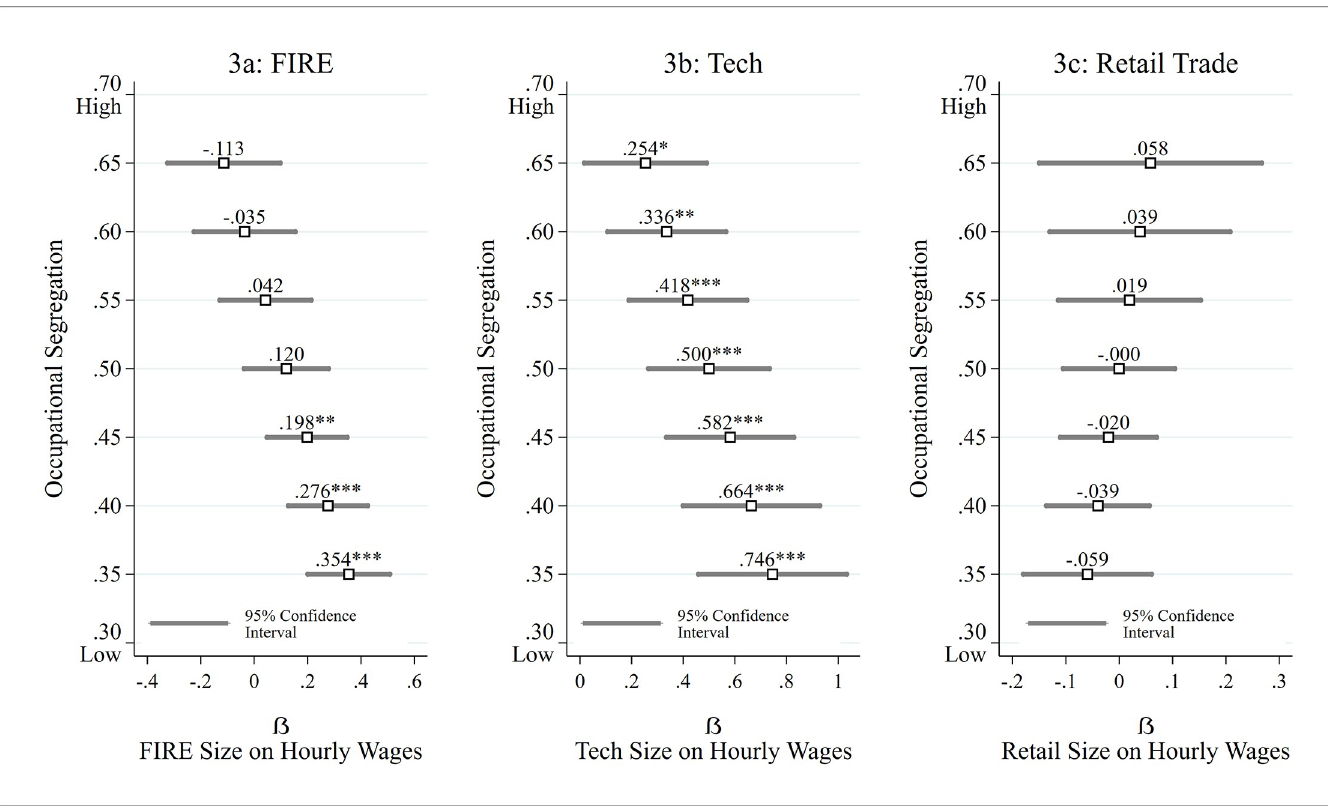
Fig 3. Coefficient for industry expansion predicting wage growth by levels of occupational gender segregation.